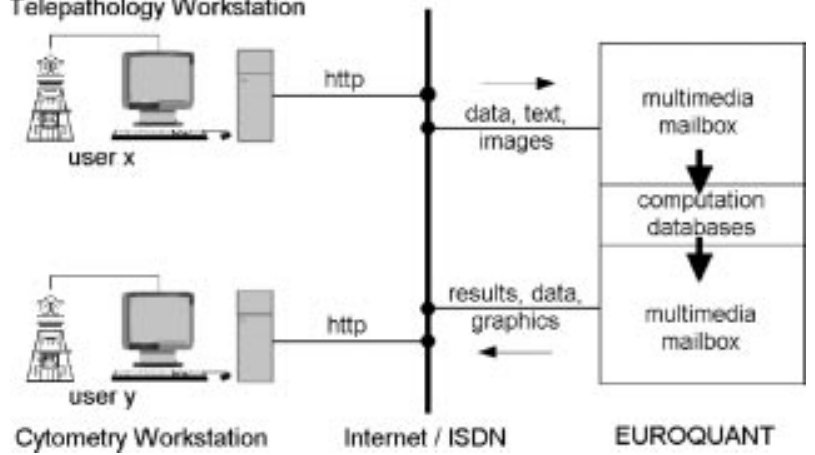
Fig. 2. The quantitation server can be accessed by different types of users via the Internet.